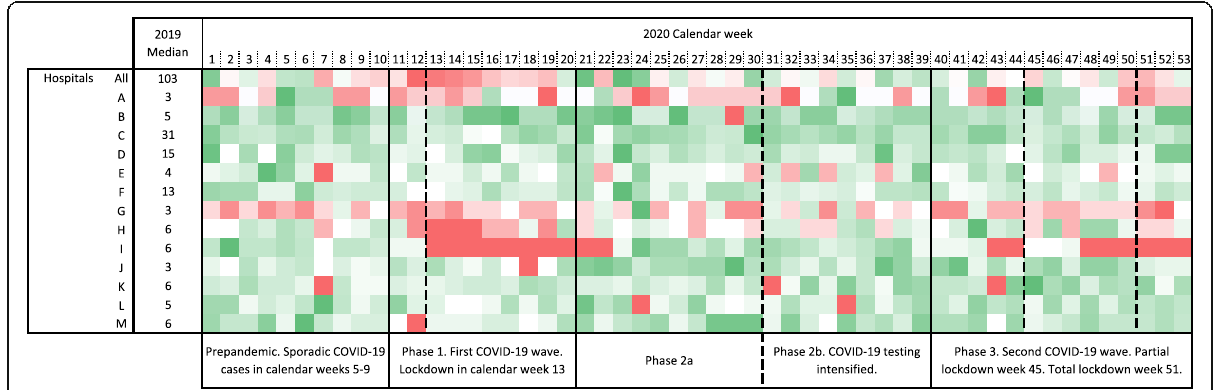
Fig. 2 Heatmap showing the number of neuroradiological emergency consultations (NECs) per calendar week in a teleradiological network for 13 hospitals compared to the reference value (median) in the year 2019. Red: number of NECs below reference value. Green: number of NECs exceeds reference value. White: number of NECs is the same as the reference